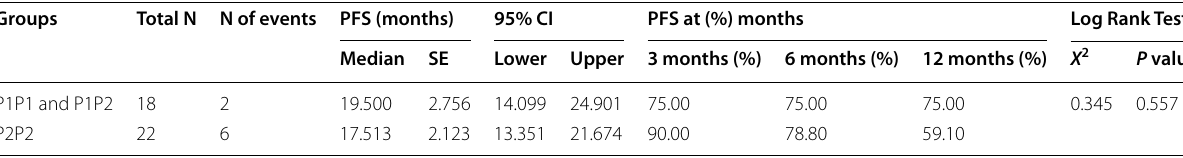
DFS disease-free survival, SE standard error, N number